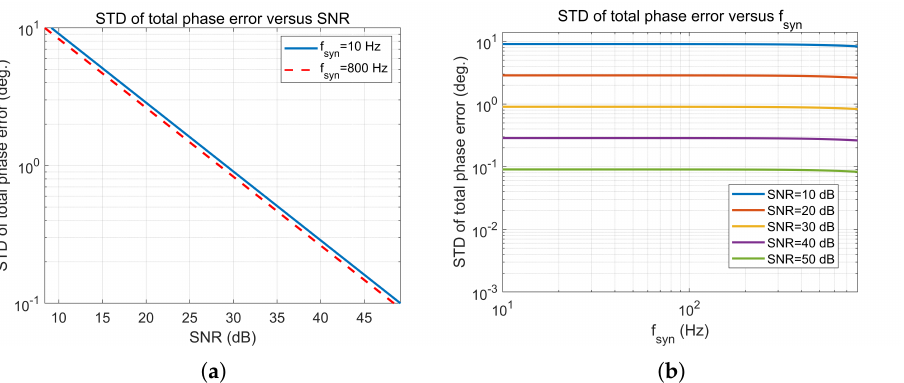
Figure 4a. In the case of different SNR, σ link versus synchronization frequency is shown in Figure 4b. It can be seen from the simulation results that f syn has little impact on the STD of phase errors in the high synchronization frequency case. The STD of total phase error σ link is mainly depends on SNR of synchronization signal. If σ link is limited to no more than 1 degree, the SNR of synchronization signal should reach 30 dB at least.